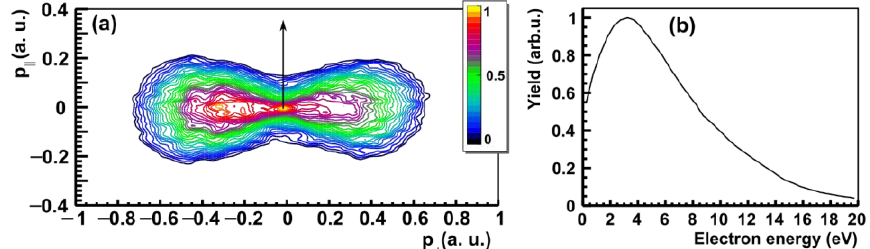
Fig. 1. (a) Yield of electrons measured in coincidence with singly ionizaed methyloxirane in the plane defined by the laser propagation direction (vertical axis) and the direction of minor axis of polarization ellipse (horizontal axis). (b) Energy distribution of